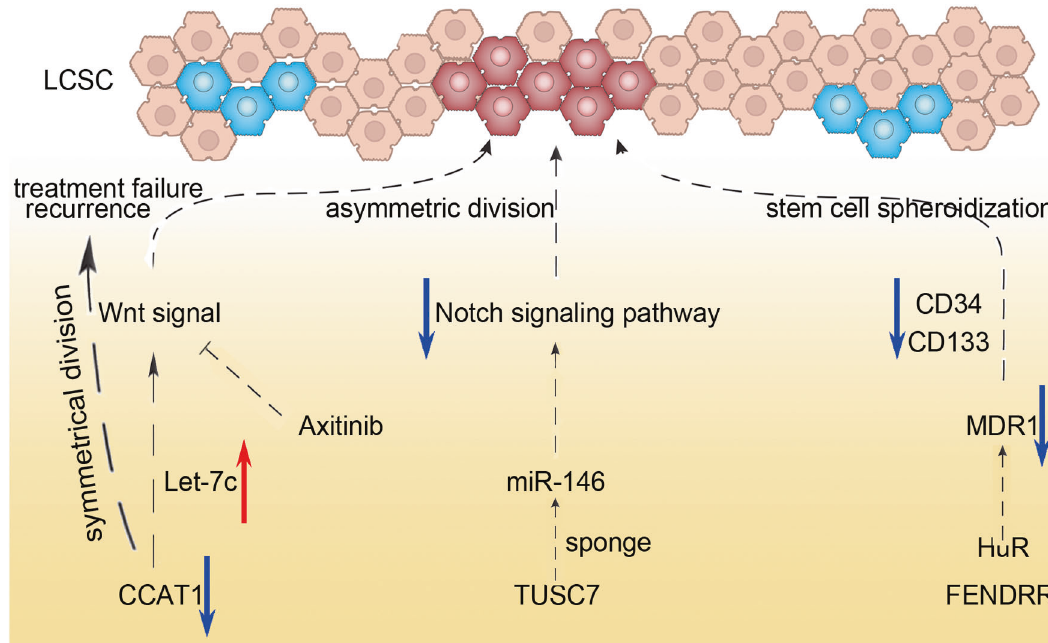
Fig. 4 Schematic of LncRNA and Lung cancer stem cells regimen in indicates that exosomes can selectively package, secrete and transfer speci fi c lncRNAs and play the corresponding biological function [50]. Exosomal lncRNA research is an important part of tumor biology. It can participate in tumor cell proliferation, invasion, metastasis, angiogenesis, drug resistance, and immu- nosuppressive microenvironment [50]. Exosomal lncRNA can be derived from tumor cells, tumor-associated macrophages, and